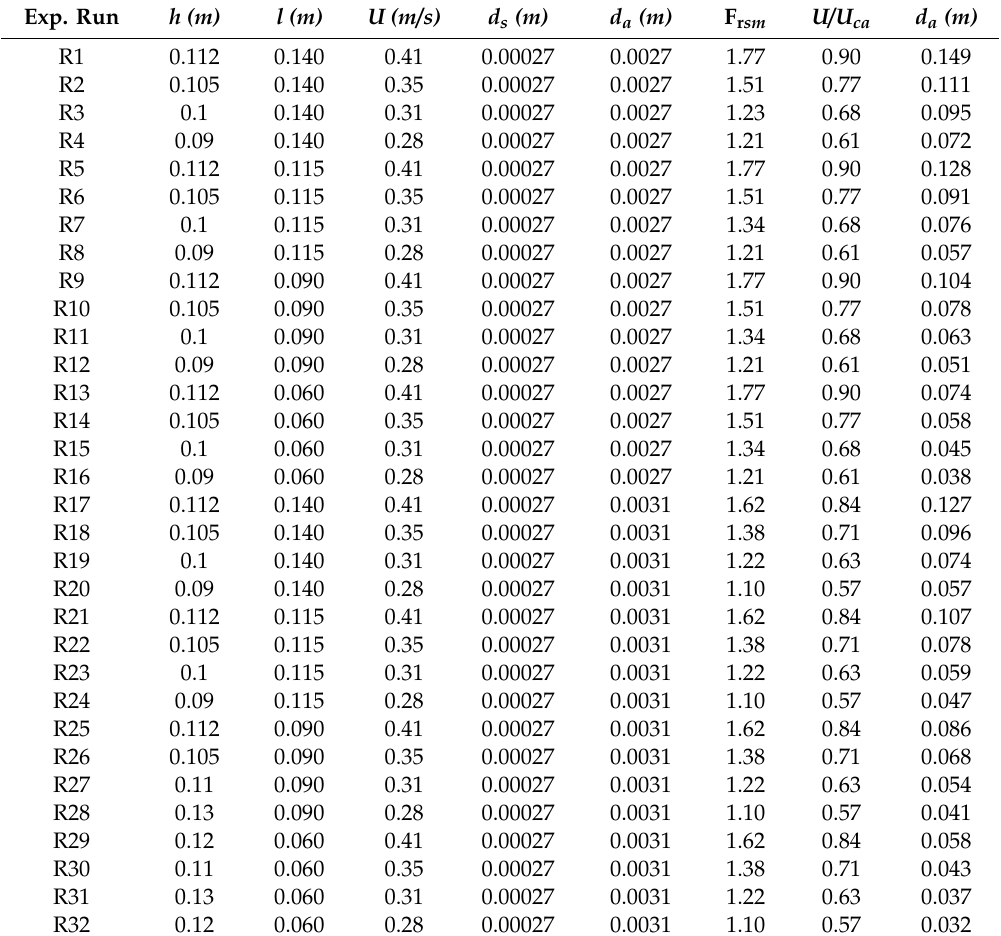
Table 1. Scour depth data at equilibrium